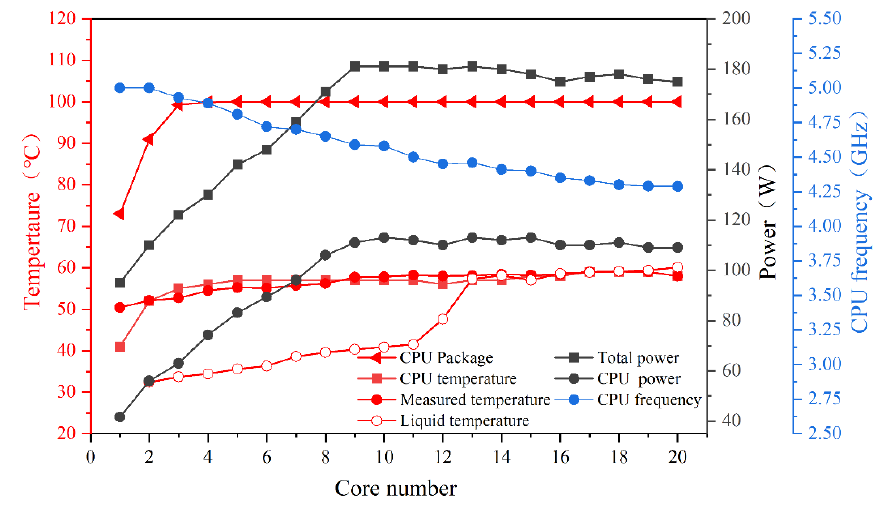
Figure 5. Direct contact boiling heat transfer.